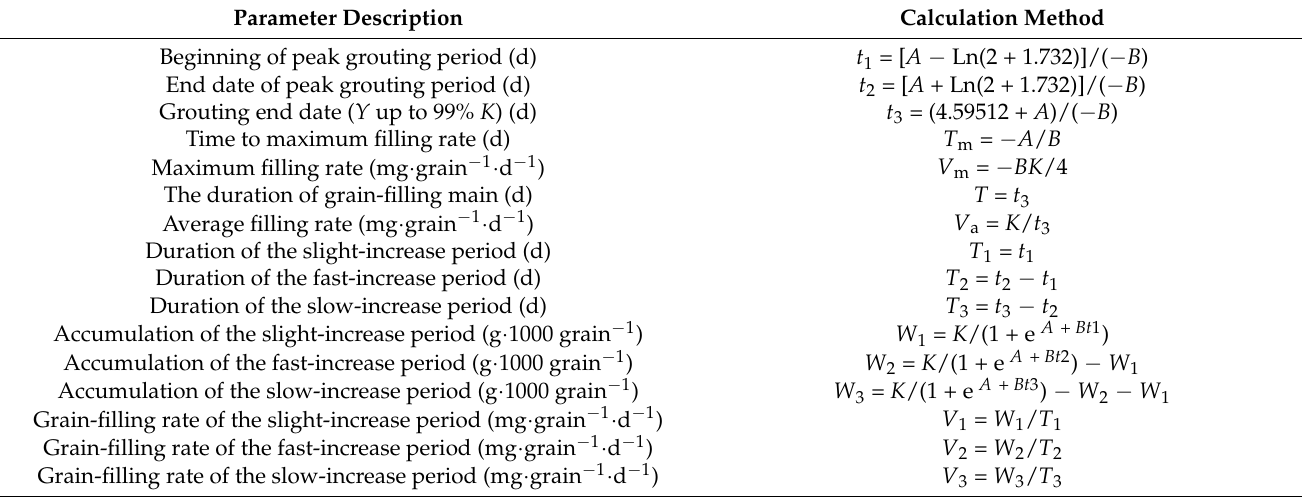
Table 2. Various grouting parameter expressions and calculation